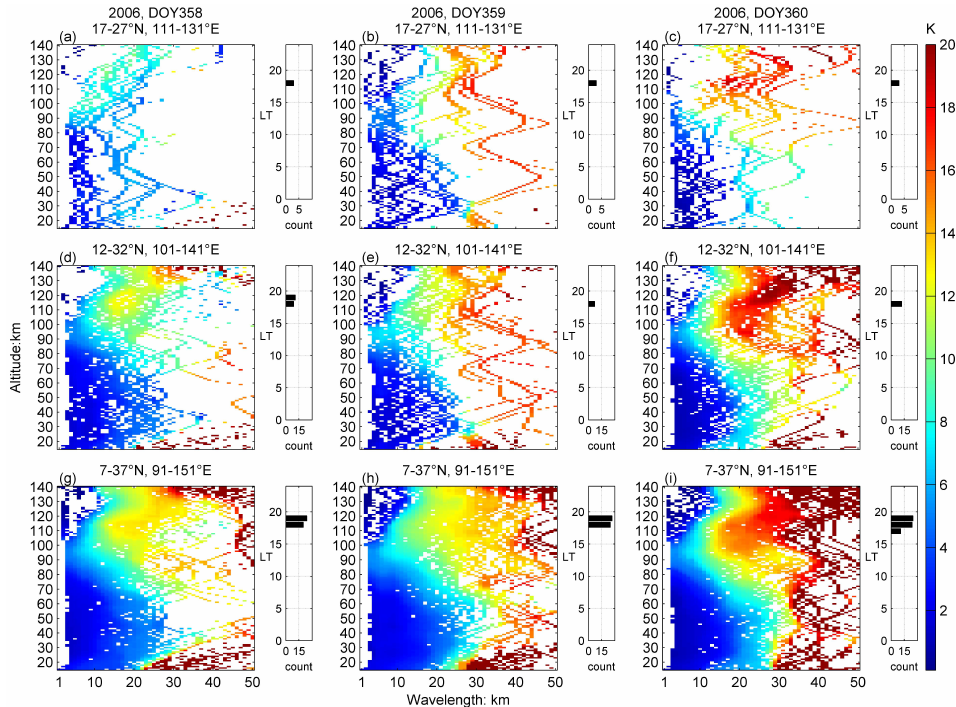
Fig. 7. The change of the Hilbert spectra in three square areas shown in Fig. 6 for three days (DOY 358, 359, and 360) for the Pingtung Doublet earthquake. The horizontal bar graphs beside the spectra denote the number and local time of the measuremets. Note that the amplitude of wavy structures with wavelength of 20–30km enhances on DOY